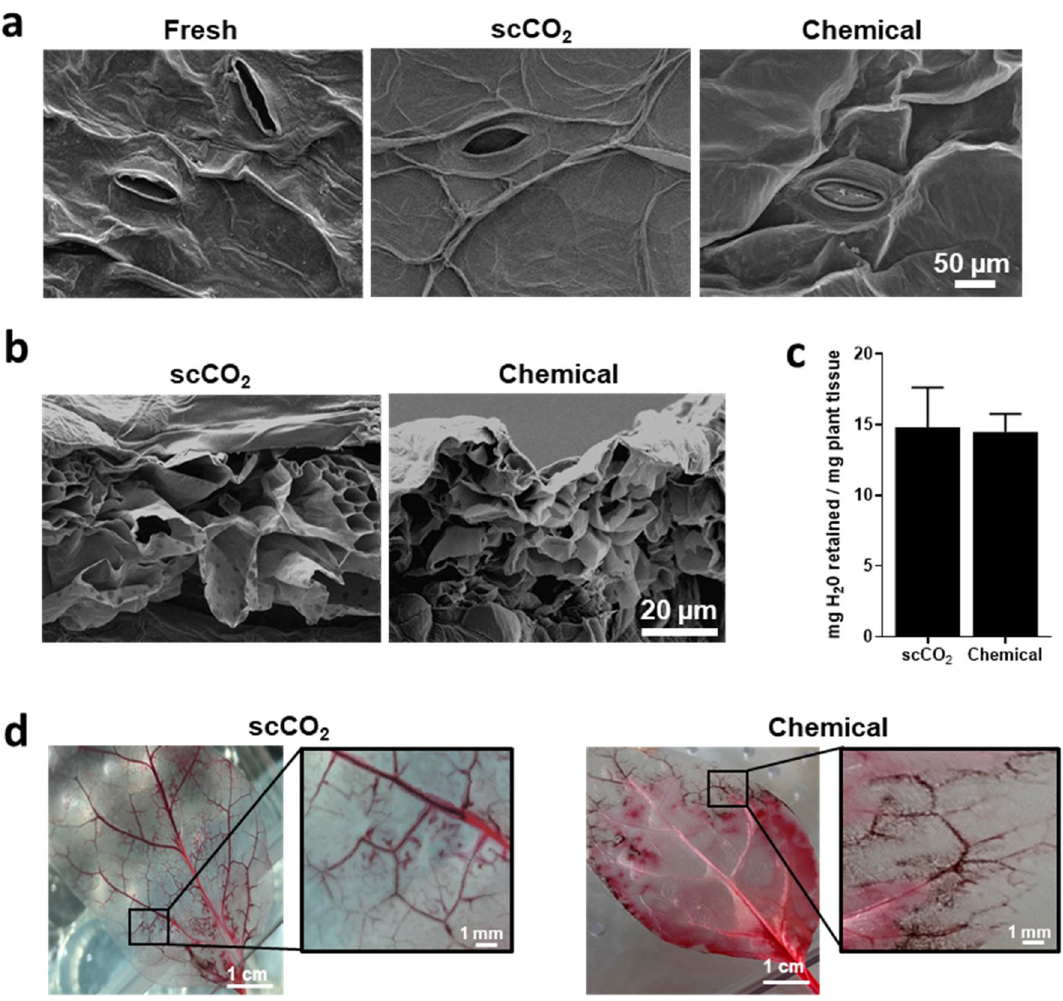
Figure 2. Scaffold structure after decellularization. ( a ) SEM surface images of a fresh spinach leaf, scCO 2 and chemically decellularized scaffolds. ( b ) Cross-sectioned SEM images of scCO 2 and chemically decellularized scaffolds. ( c ) Comparison of the mass of water (H 2 O) retained by the scCO 2 and chemically decellularized scaffolds (n = 7). ( d ) Images of scCO 2 and chemically decellularized scaffolds perfused with red dye showing the integrity of vascular network, down to the capillary level